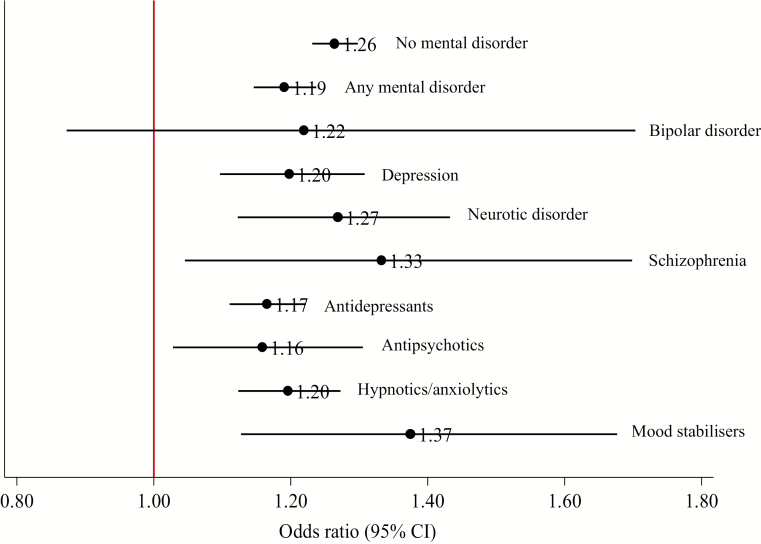
Stratified by mental disorder: The association of prescribing varenicline compared with NRT and smoking cessation at 2-years follow-up. Fully adjusted odds ratios and 95% confidence intervals from logistic regression models. Fully adjusted models were adjusted for: age, sex, days in history, IMD, number of GP visits 1-year before first prescription, BMI, year of first prescription, history of major physical morbidity (Charlson Index), alcohol misuse ever, drug misuse ever, bipolar ever, depression ever, neurotic disorder ever, self-harm ever, other mental disorder ever, antidepressant prescription ever, antipsychotic prescription ever, hypnotics/anxiolytics prescription ever, other psychoactive medication ever, other behavioral/neurologic disorder ever. Missing BMI and IMD values were imputed using multiple imputation.24 No mental disorder diagnosis or psychoactive medication prescription (N = 156 857); any mental disorder diagnosis or psychoactive medication prescription (N = 78 457); bipolar (N = 2011); depression (N = 17 168); neurotic disorder (N = 8394); schizophrenia (N = 8,394); antidepressants (N = 56 756); antipsychotics (N = 11 829); hypnotics/anxiolytics (N = 31 291); mood stabilizers (N = 4727).